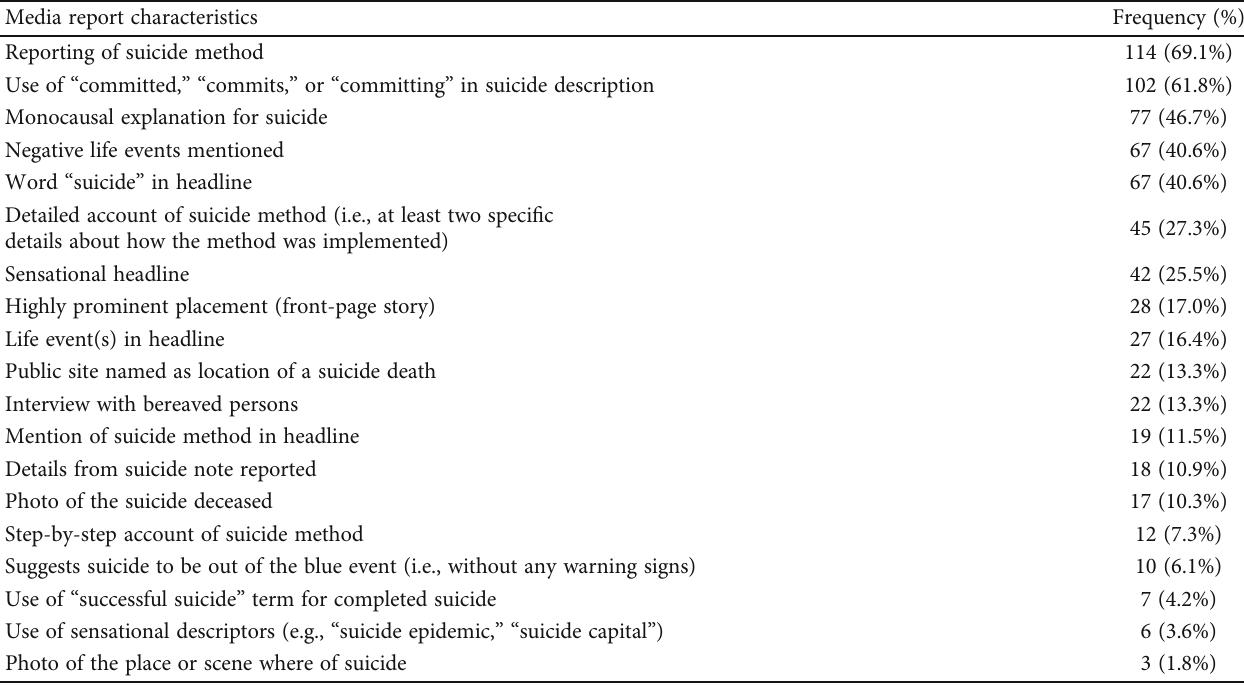
Table 1: Potentially harmful media reporting characteristics according to World Health Organization suicide reporting guidelines ( N = 165 articles).